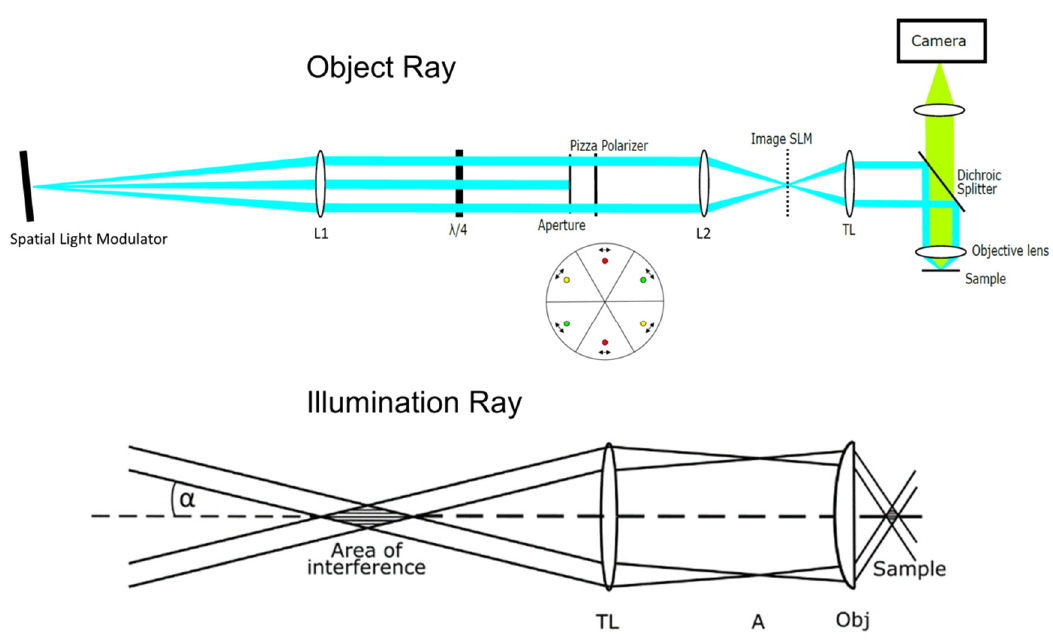
Figure 2. Experimental setup for SIM: The object ray creates an image of the SLM pattern in the plane of the sample upon illumination by the parallel beam of an argon ion laser ( λ 0 = 488 nm expanded by a telescope to a diameter of 10 mm, not shown); the illumination ray is focused in the aperture plane A of the objective lens and results in two parallel beams interfering in the plane of the sample (TL = tube lens, Obj = microscope objective lens). The inset shows a scheme of the “pizza polarizer” with 6 areas of different polarization.